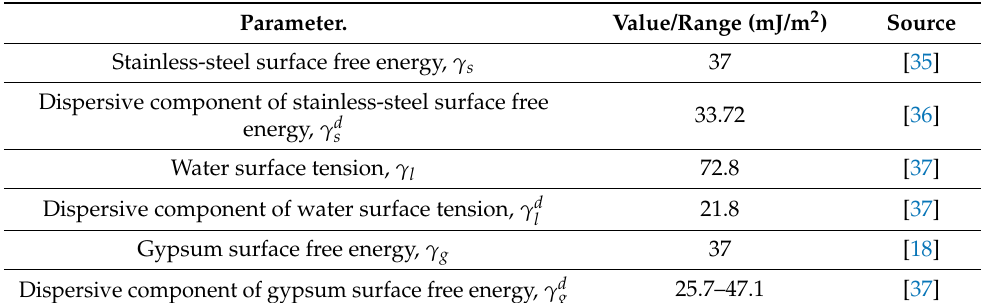
Table A1. Parameters used to calculate contact angle.